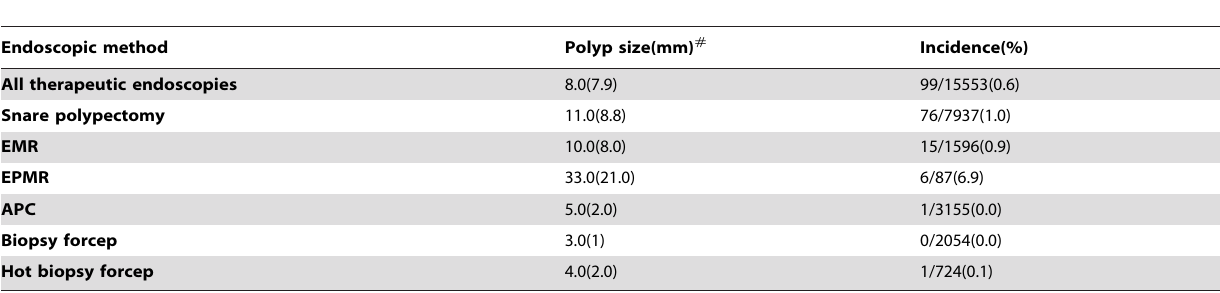
Table 1. The average sizes of polyps dealt with different endoscopic methods and the rates of post-polypectomy hemorrhage of each method to handle